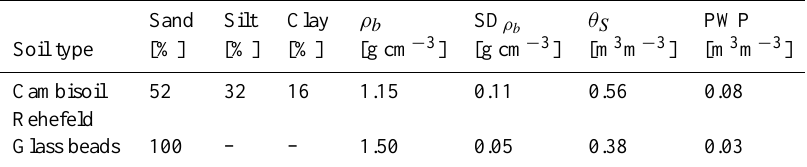
Table 2. Soil texture (following the United States Department of Agriculture (USDA), 1993 classification), bulk density ρ b , saturated soil moisture θ S and permanent wilting point (PWP) of the dominating Cambisoil at the study area Rehefeld, and experimental glass beads. ρ and θ S were estimated on 1.00m 3 soil cores with grain density of 2.65gcm − 3 . PWP is the soil moisture at 160m pressure head. The glass beads have a grain size ranging from 0.25 to 0.5mm in diameter. Standard deviation is abbreviated as